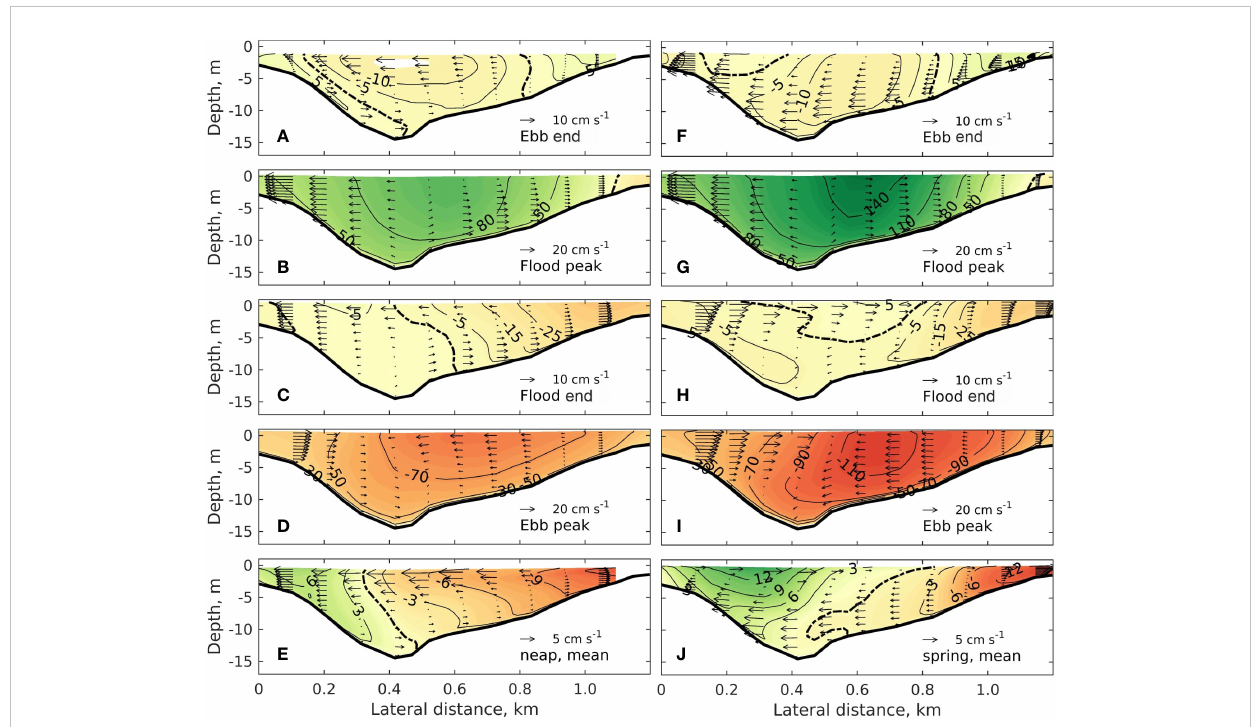
FIGURE 4 Transverse distributions (looking seaward) of the currents in along-channel (contours, the green colors are fl owing toward the viewer) and cross- channel (arrows) directions at different phases of the neap (left column) and spring (right column) tides. The fi rst to the fourth rows show the end of ebb (the cross-sectional mean of the along-channel ebb fl ow is zero) (A, F) , the fl ood peak (the cross-sectional mean of the along-channel fl ood fl ow is the maximum) (B, G) , the end of fl ood (cross-sectional mean along-channel fl ood fl ow is zero) (C, H) and the ebb peak (cross-sectional mean along-channel ebb fl ow is maximum). (D, I) The fi fth row shows the tidal mean. (E, J) Thick dashed curves indicate the 0 m s − 1 contours.